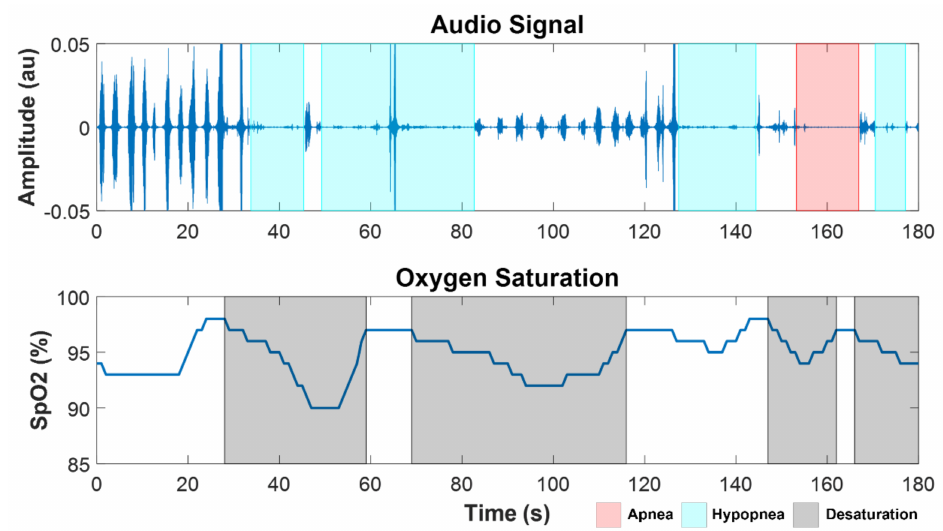
Figure 2. Example of a segment of audio and SpO 2 signals from a SCI patient with severe OSA (SCI 4, AHI = 60 h − 1 ), showing apnea (red), hypopnea (cyan), and desaturation (black) events.